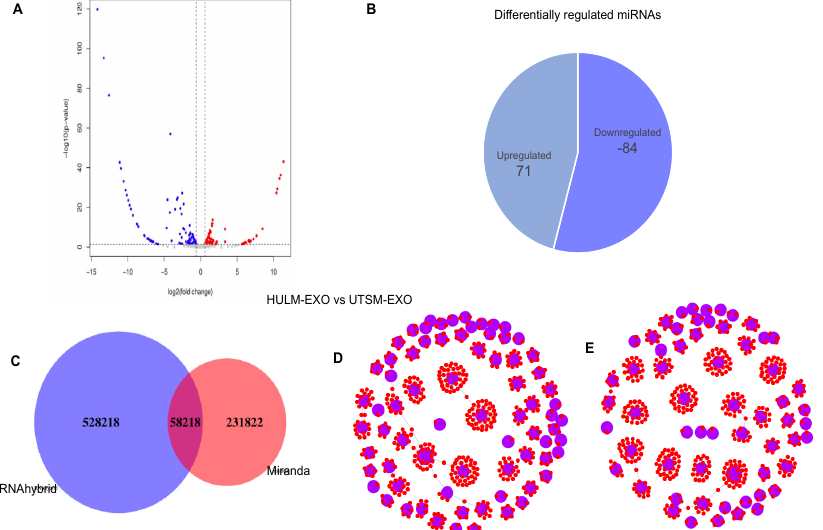
Figure 5. MicroRNA profiling of exosomes from HULM and UTSM cell lines. ( A ) A volcano plot demonstrated a differential pattern of miRNA expression between HULM-EXO and UTSM-EXO sample. The gray dots represent the miRNAs without differential expression, the blue dots represent the differentially downregulated miRNAs, and the red dots represent the upregulated miRNAs. ( B ) Statistical analyses demonstrated that there were 71 differentially upregulated and 84 downregulated miRNAs in HULM-EXO compared to UTSM-EXO ( p < 0.05). ( C ) The target genes of known and novel miRNAs were predicted using miRanda and RNAhybrid software, and the corresponding relationship between miRNAs and target genes were obtained; Venn diagram showed the miRNA prediction target genes. ( D , E ) Network relationships of differentially downregulated and upregulated miRNA candidate target genes were performed, the blue dots indicated miRNA (known and novel), the red dots indicated the candidate target gene, and the lines indicated the interaction.